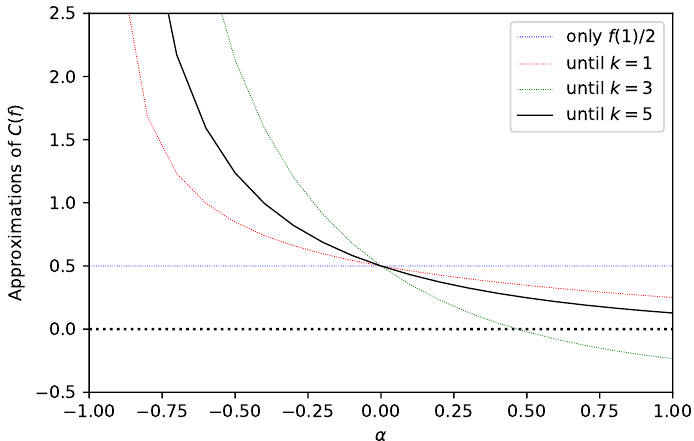
Figure 1. Approximations of the RCAS C (( − 1 ) n − 1 f ) versus α for the series of coefficients of the Grünwald–Letnikov fractional operator, under Formula (44), evaluated until k = 5, depending on α